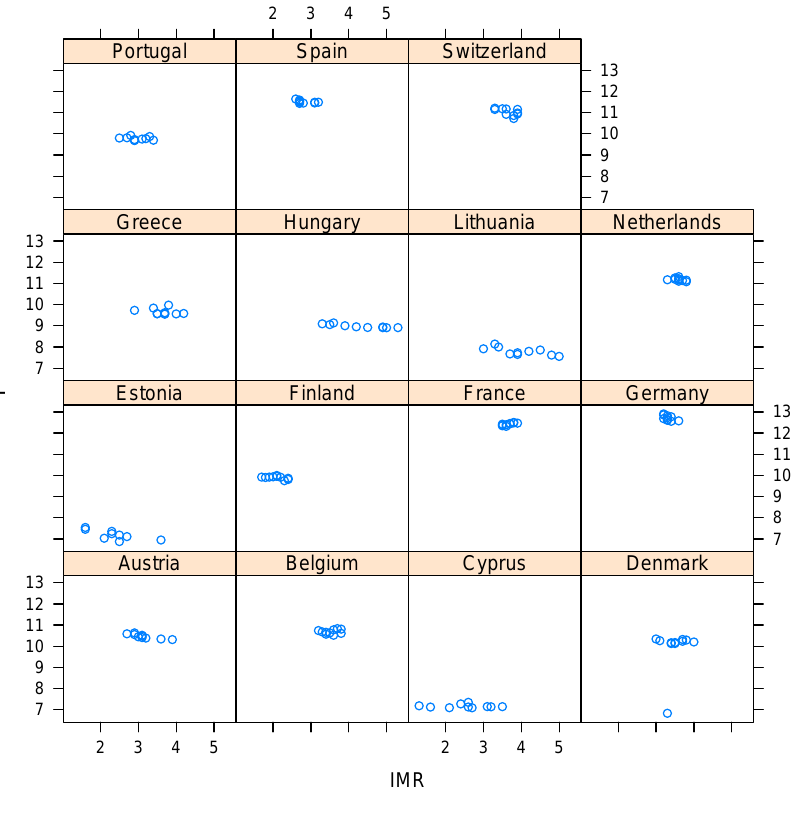
Figure 7. Healthcare expenditures versus